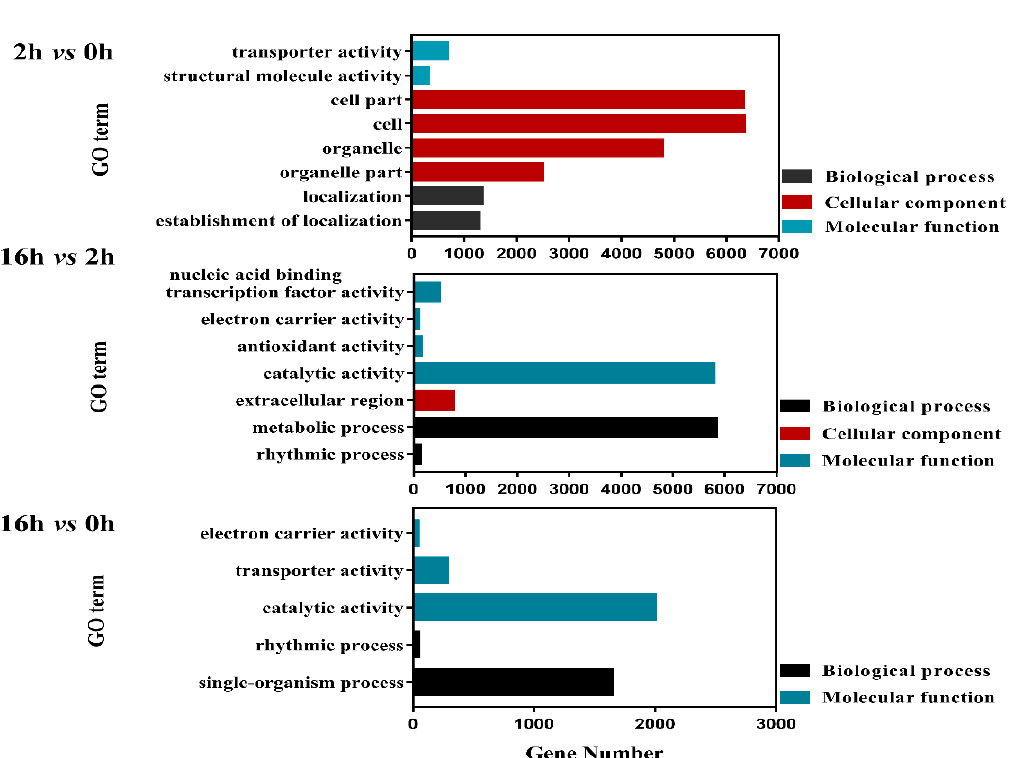
Figure 5. Bar plots of GO enrichment of DEGs with increased expressions ( q value < 0.05). Figure 4. Bar plots of GO enrichment of DEGs with increased expressions (